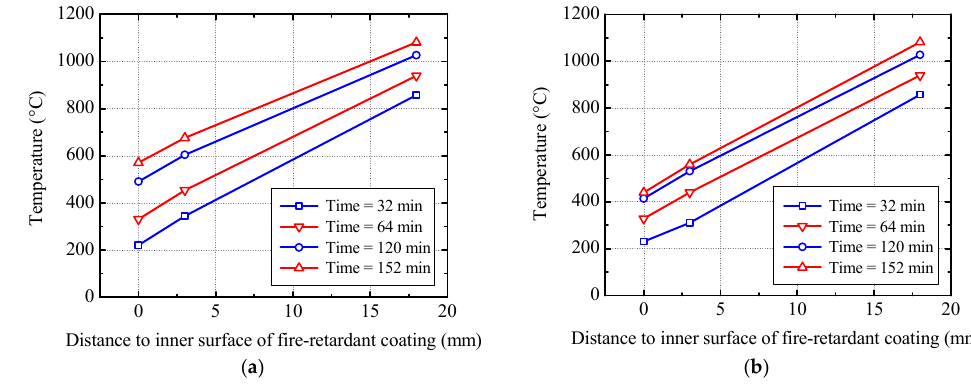
Figure 19. Temperature distribution within fire-retardant coating: ( a ) Temperature of Thermocouples 9s and 9 and that in furnace and ( b ) Temperature of Thermocouples 10s and 10 and that in furnace.